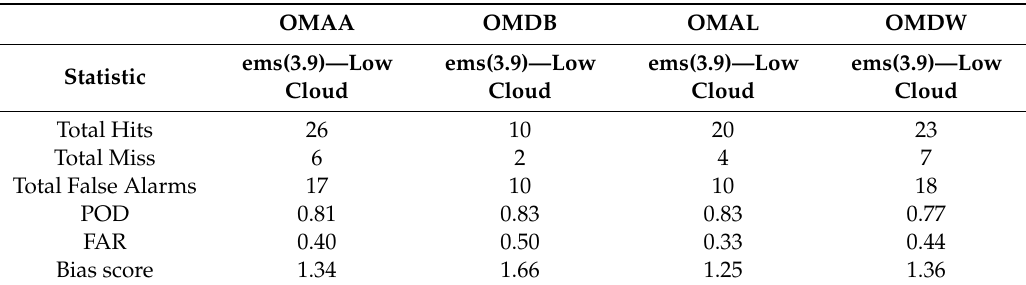
Table 2. Dec 2016–Mar